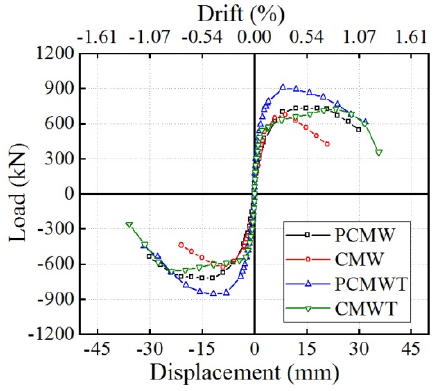
Figure 8. Skeleton curves of the test walls.